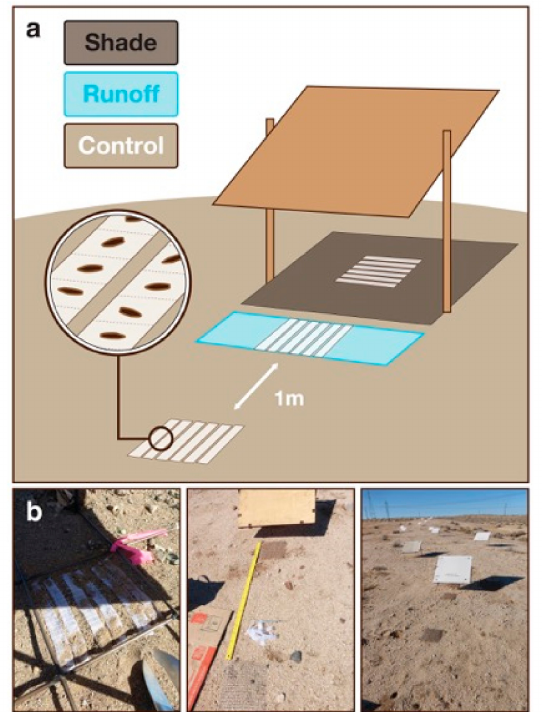
Figure 1. Seed bank packet and solar energy development microhabitats experimental design. ( a ) Graphical representation of the seed bank installation design. ( b ) Seed bank packet installation in fall 2016. Seed bank packets were deployed in Shade, Runo ff , and Control microhabitats at each site (Caliche Pan site shown above).